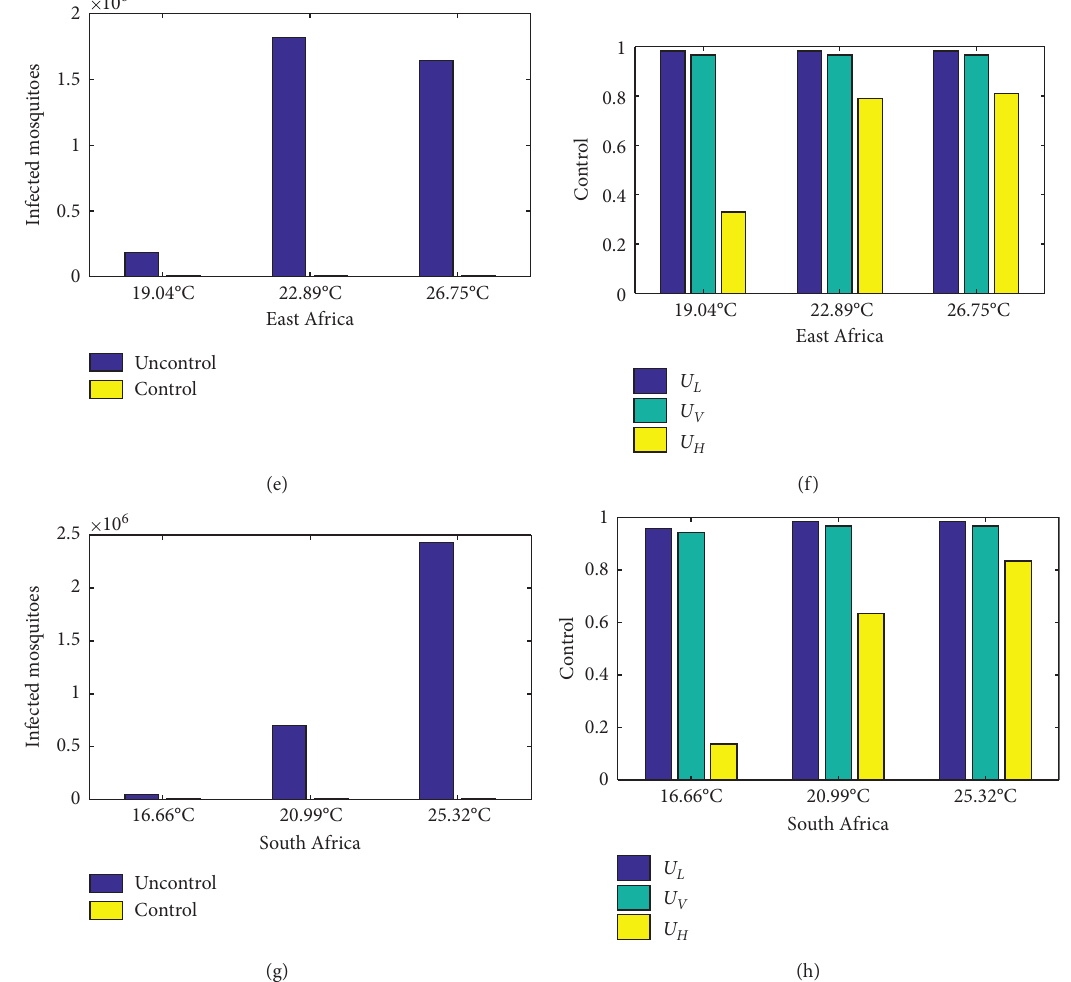
Figure 12: Simulations of the malaria model (2) as a function of time in the suitable temperature ranges. (a, c, e) The monthly total number of infected mosquitoes with control, and (b, d, f) optimal controls u H ( t ) , u L ( t ) , and u V ( t ) , in West, Central, East, Central, and South Africa.